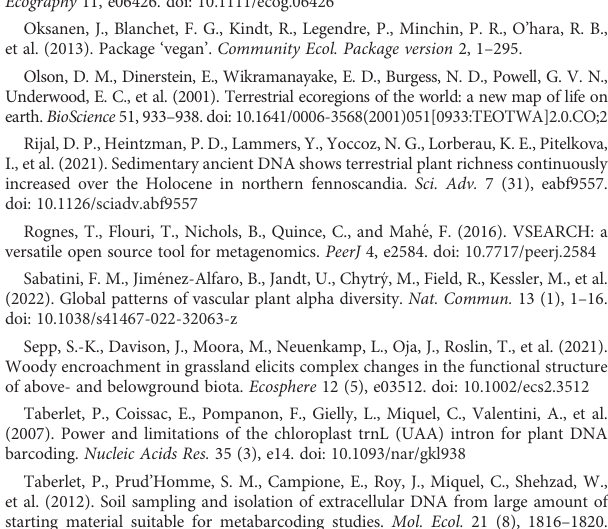
Taberlet, P., Coissac, E., Pompanon, F., Gielly, L., Miquel, C., Valentini, A., et al. (2007). Power and limitations of the chloroplast trnL (UAA) intron for plant DNA Taberlet, P., Prud ’ Homme, S. M., Campione, E., Roy, J., Miquel, C., Shehzad, W., et al. (2012). Soil sampling and isolation of extracellular DNA from large amount of starting material suitable for metabarcoding studies. Mol. Ecol. 21 (8), 1816 – 1820. doi: